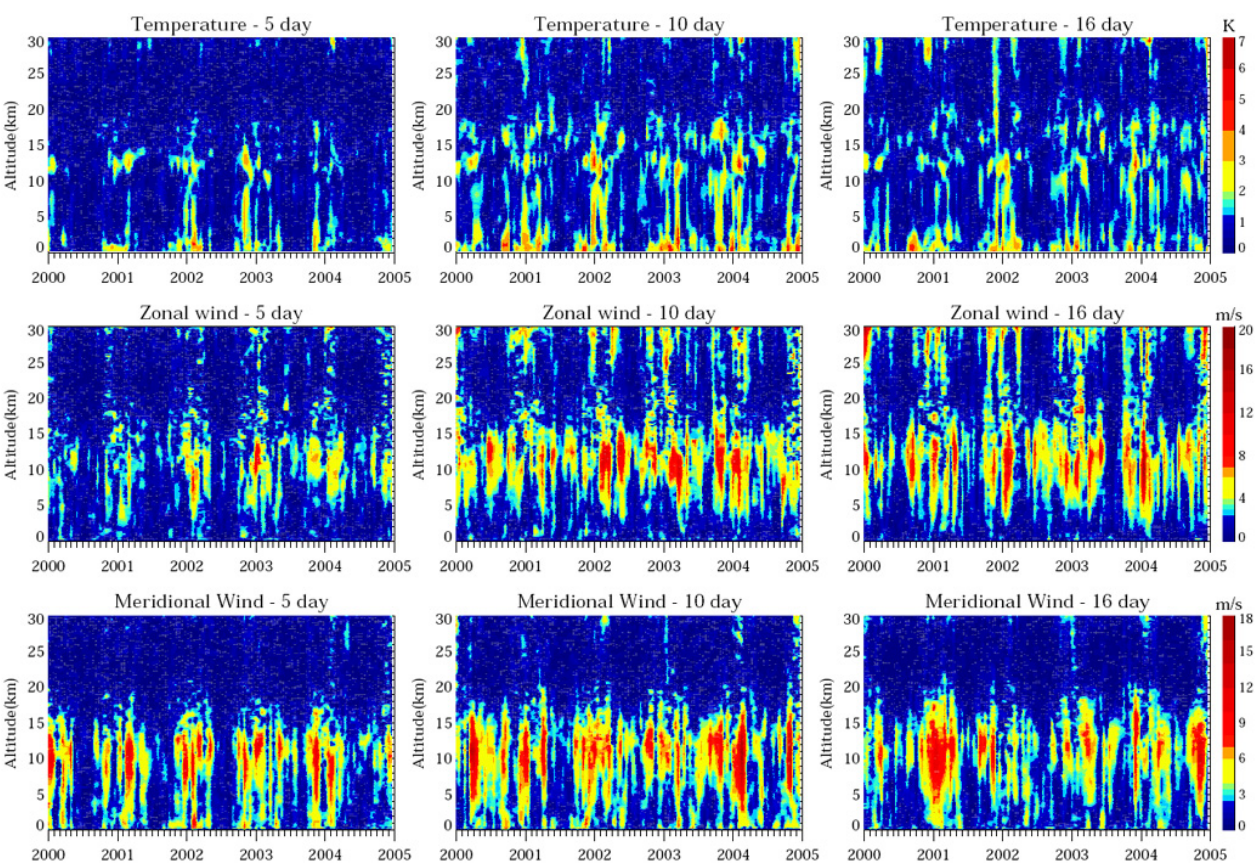
Fig. 4. Time-height cross-sections of the harmonic fitting amplitudes of 5-, 10-, and 16-day waves in the disturbances of the temperature, zonal and meridional winds over Fort Worth Station during